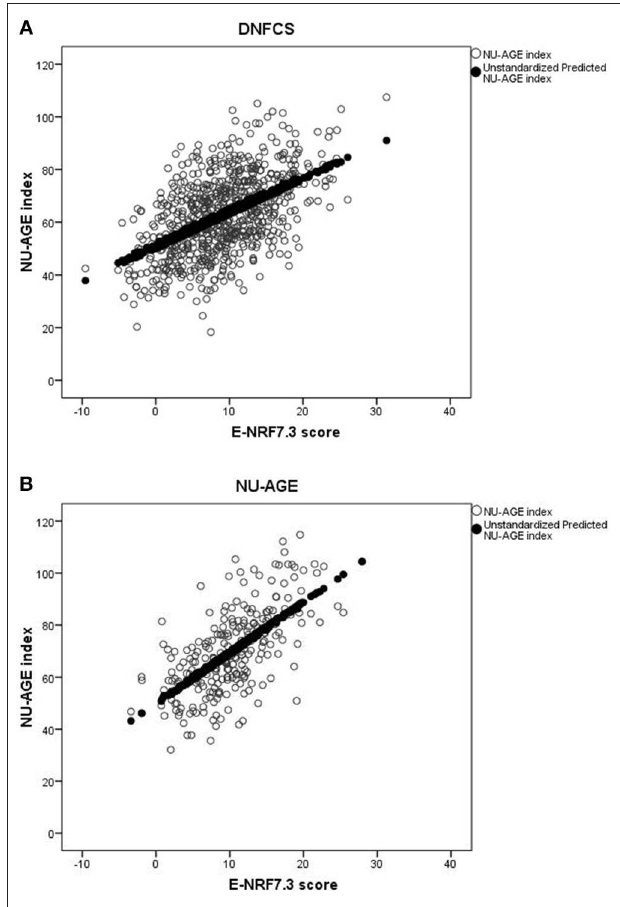
FIGURE 1 | Actual and predicted E-NRF7.3 scores and NU-AGE index values in DNFCS (A) and NU-AGE (B)